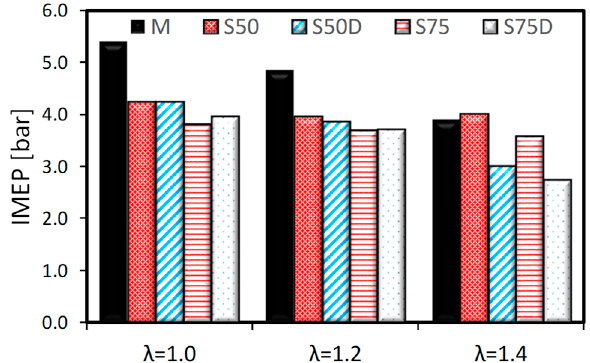
Figure 7. Indicated mean e ff ective pressure for M, S50, S50D, and S75D at fixed SA ( − 7 CAD ATDC) and air-fuel dilution from 1.0 to